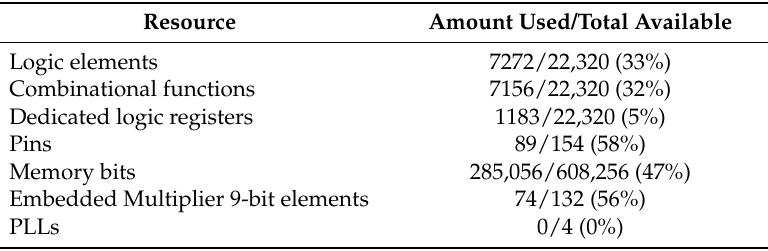
Table 5. Consumed FPGA